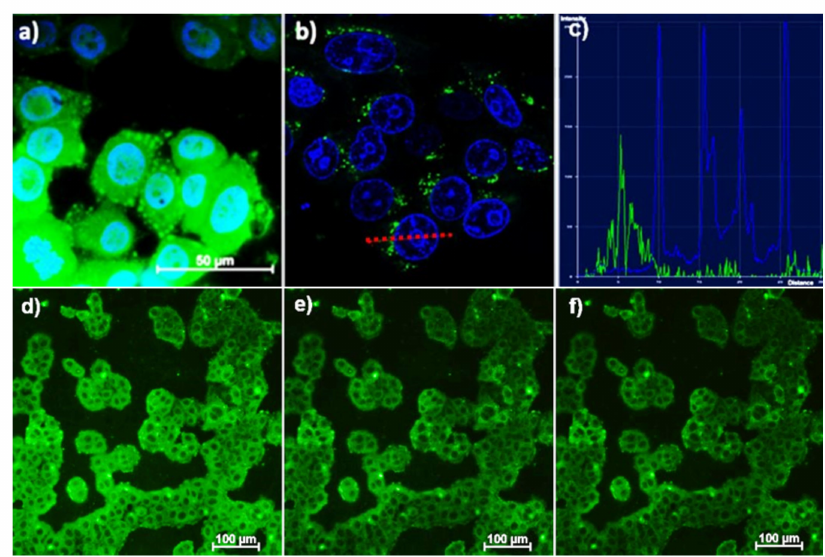
Figure 15. Fluorescent microscopy ( a ) and confocal microscopy ( b ) images of M-Hela cells incubated with PSS-[Tb 2 ( 43 ) 2 ]. The cell nuclei are stained by DAPI ( a ) and Hoechst 33342 ( b ). The graph of luminescence intensity of Hoechst 33342 (blue) and nanoparticles (green) ( c ) between two points, designated on ( b ) with red line, demonstrating the nanoparticles location outside the cell’s nu- cleus. Fluorescent microscopy images of M-Hela stained by PSS-[Tb 2 ( 34 ) 2 ] at different